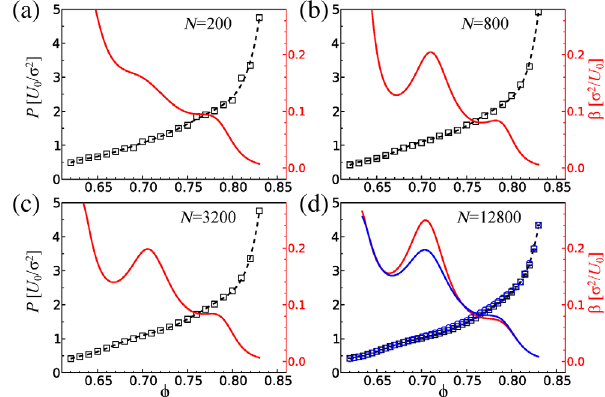
FIG. 12. EOS P ð ϕ Þ (squares) and compressibility β (red curve) for the 2D binary systems with N ¼ 200 (a), 800 (b), 3200 (c), 12 800 (d) particles. The reverse decompression process [blue curve in (d)] also shows the same five regimes as above and only a weak hysteresis around ϕ ¼ 0 . 7 .